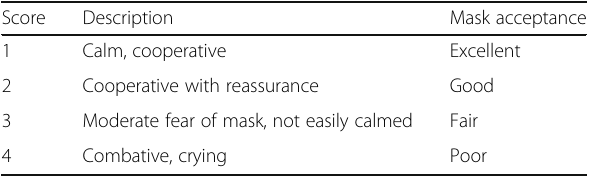
Table 2 Anxiety scale (Akin et al., 2012)